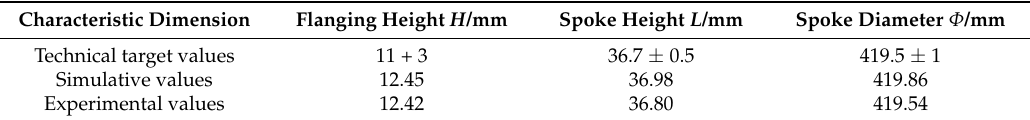
Table 5. Experimental and simulative results of the thickness of each node on the selected path. Nodes Number